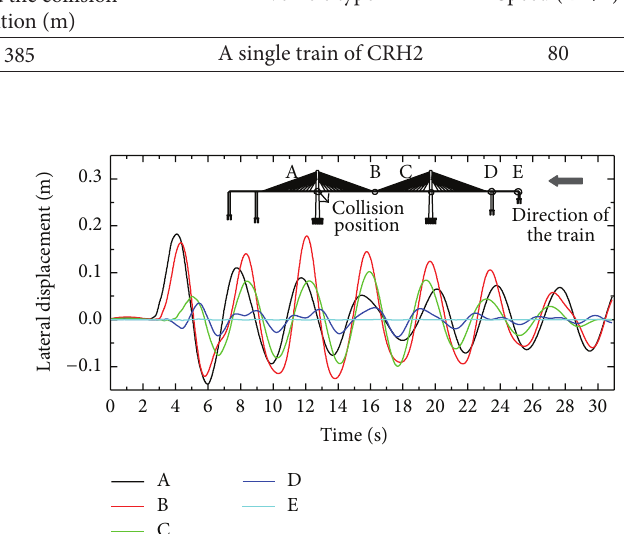
Figure 10: Lateral displacement calculated (in the down direction).